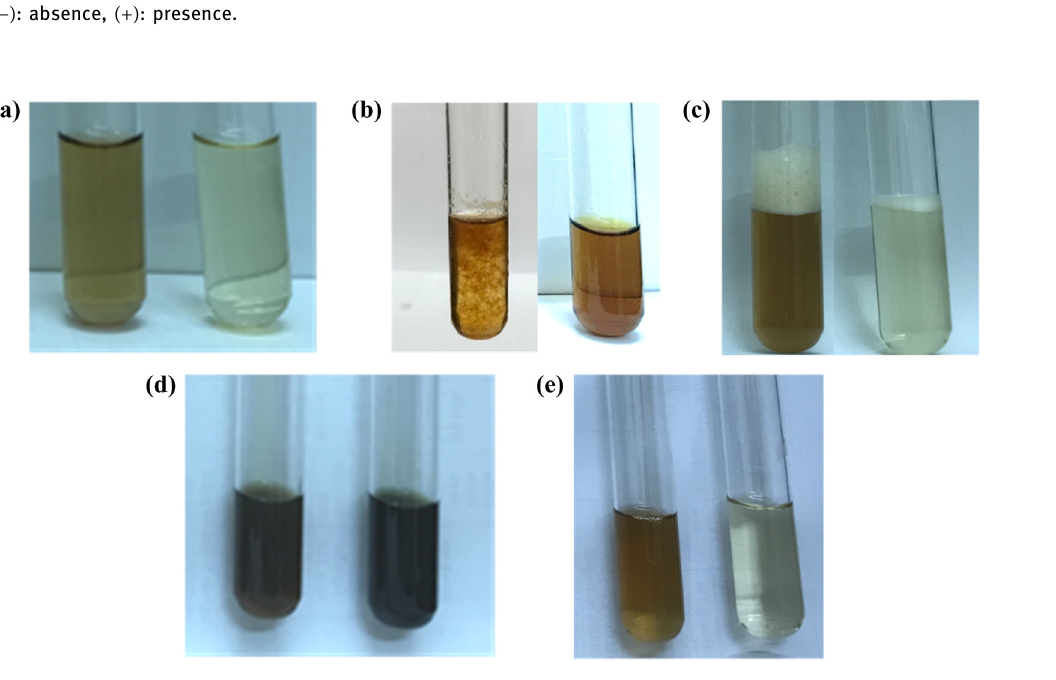
Figure 2: Qualitative test of phytoconstituents in OT - ext ( left ) and P.uri.ext broths ( right ) : color of aqueous extracts ( a ) , Wagner ’ s test ( b ) , foam test ( c ) , FeCl 3 test ( d ) , and Lieberman - Burchard test ( e )